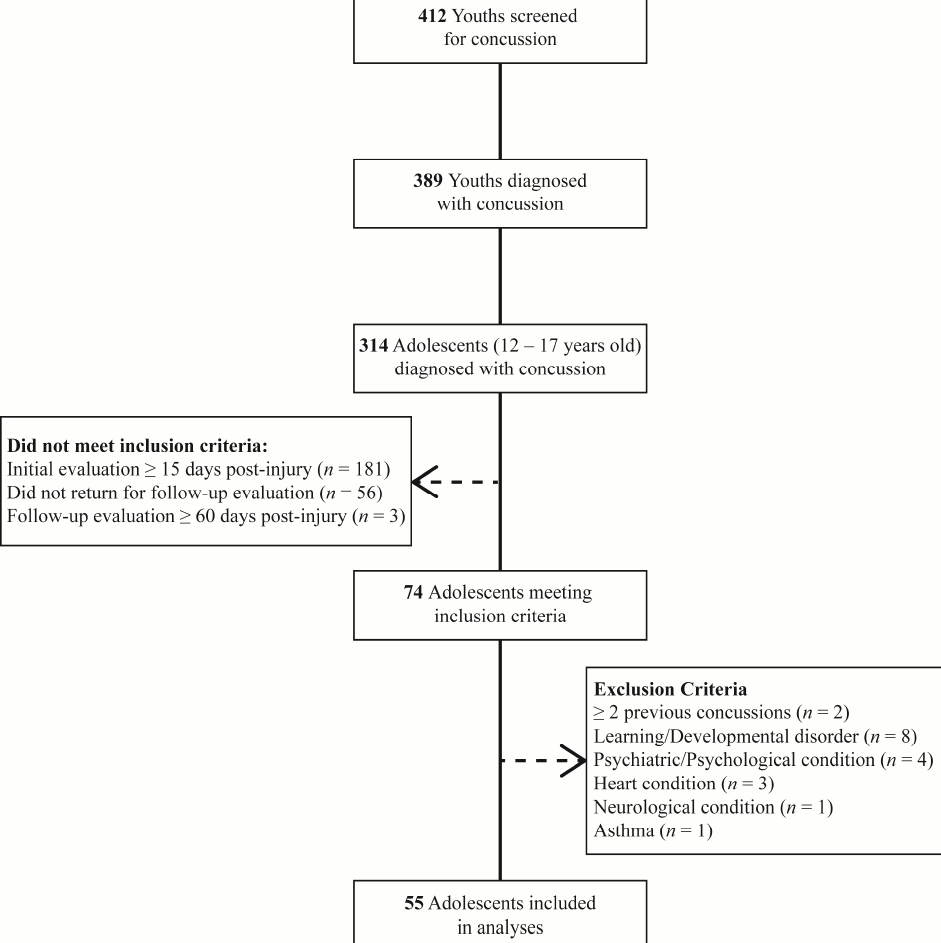
Figure 1. Flow diagram of the sample participants.